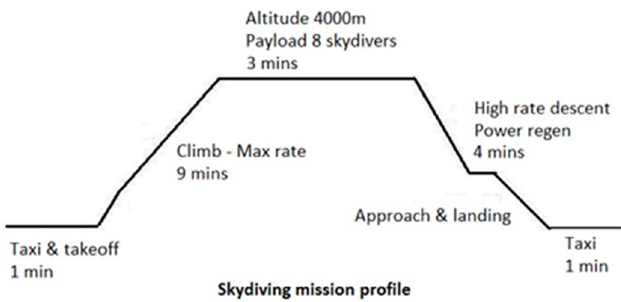
Figure 2. Typical skydiving mission profile.